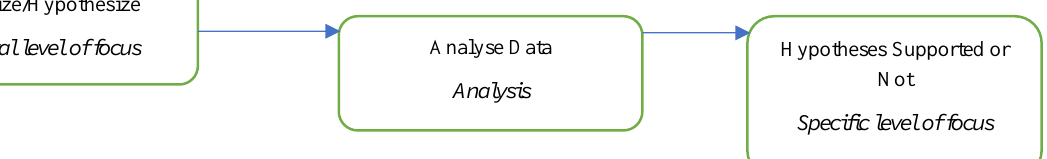
Figure 2: Deductive Research Approach; Source: Collier